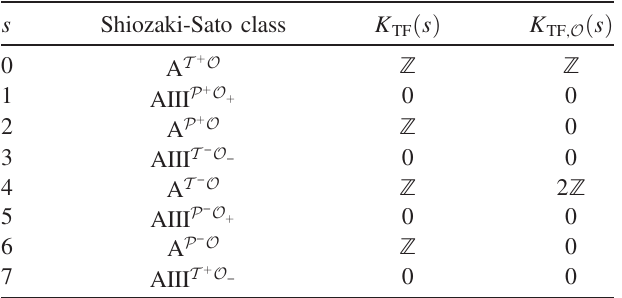
s j 0 ; 0 ; 0 ; 0 Þ for complex TF ; O ð